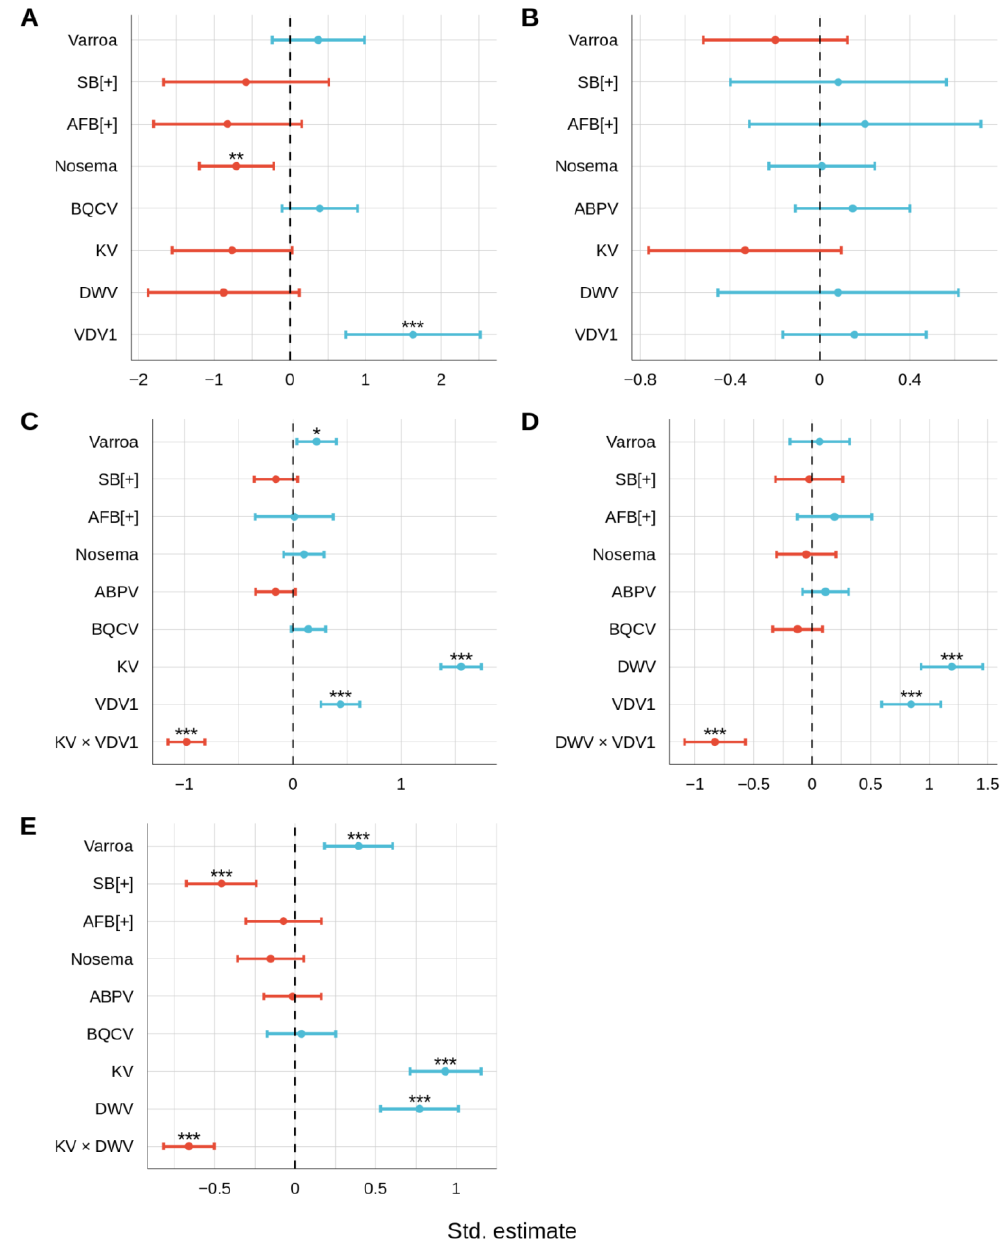
Figure 6. Standardized estimates from the GLMM analysis of Acute Bee Paralysis Virus (ABPV) ( A ), Black Queen Cell Virus (BQCV) ( B ), deformed wing virus (DWV) ( C ), Kakugo Virus (KV) ( D ), and Varroa Destructor Virus-1 (VDV1) ( E ). Green lines indicate 95% confidence intervals that have an overall positive relationship, while red lines indicate a negative relationship. * p < 0.05, ** p < 0.01 and *** p < 0.001.